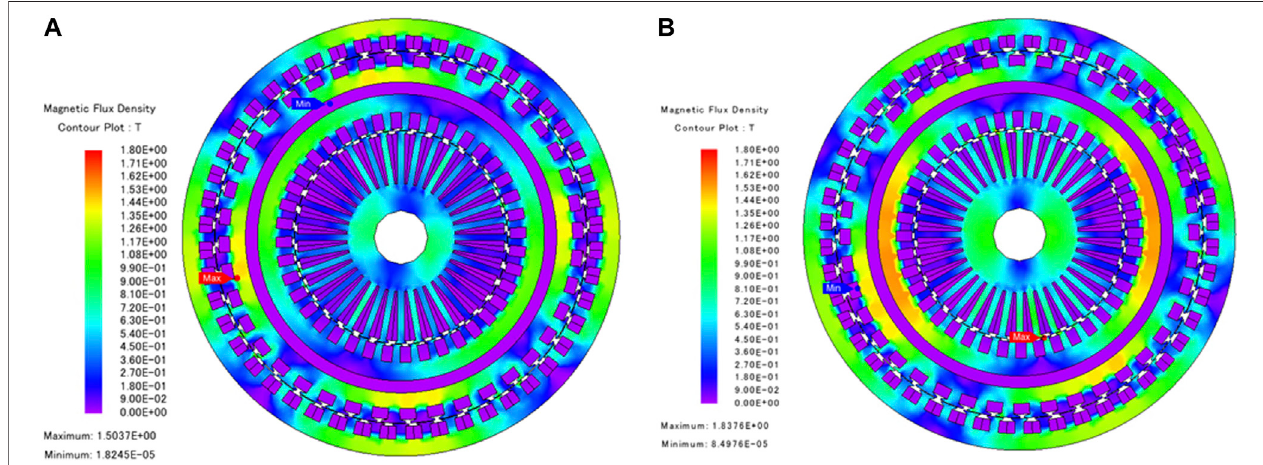
FIGURE7 | Magnetic fl ux densitiesof DC and SC modes (A) DC mode (CW 12.5 Hz, PW 50 Hz, 3,750 r/min) (B) SC mode (CW 12.5 Hz, PW 50 Hz, 1,250 r/min).